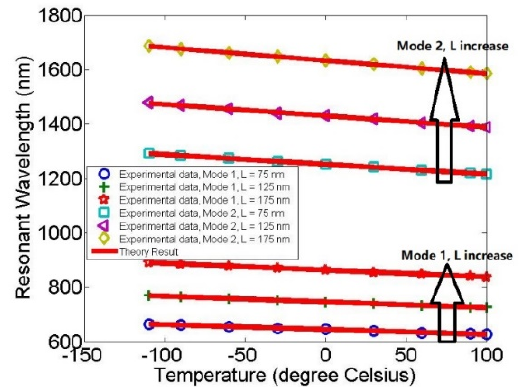
Figure 5. The wavelength at the resonant peak expressed as a function of the temperature for different structural parameters, L. The blue circle, green plus, and red asterisk correspond with L = 75 nm, L = 125 nm, and L = 175 nm, respectively, in mode 1; the cyan square, purple triangle, and yellow diamond correspond with L = 75 nm, L = 125 nm, and L = 175 nm, respectively, in mode 2. The experimental data were calculated by the finite element method and the theoretical result was further validated by MATLAB, corresponding to the red solid